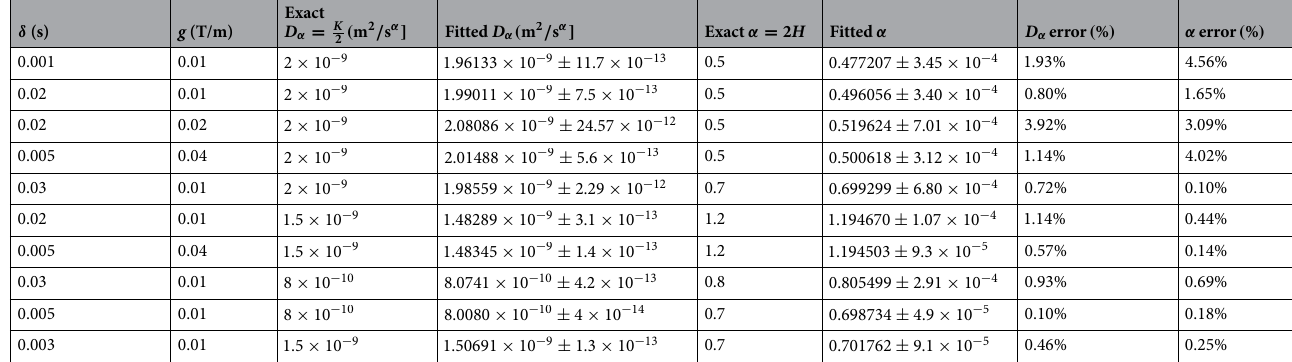
Table 2. Fit parameters of the synthetic curves obtained from FBM trajectories.